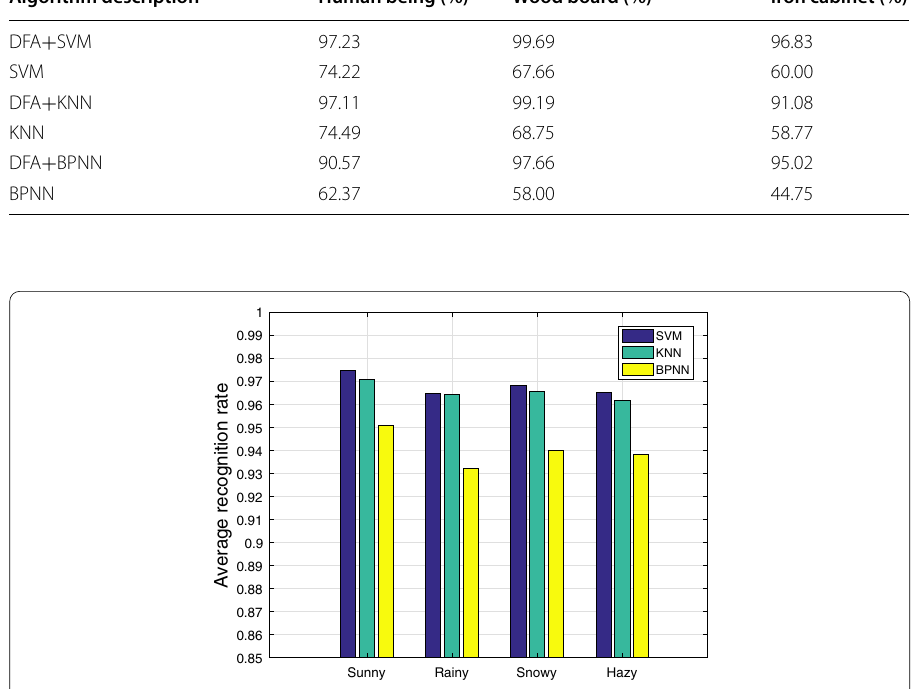
Fig. 11 Stability of DFA algorithm by cross-validation (mixed data set as training